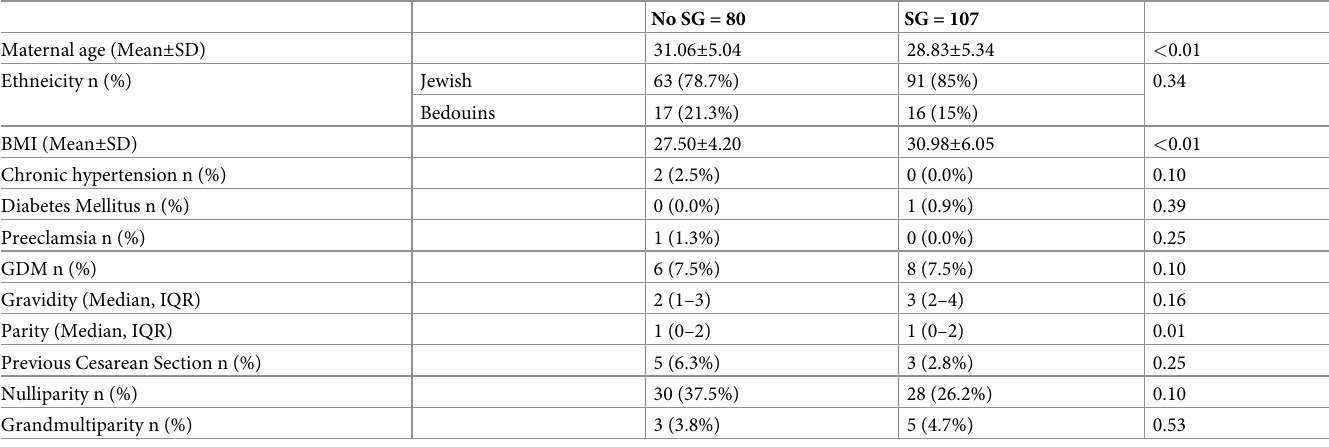
Table 1. Demographic and clinical maternal characteristics of the study groups stratified by the presence of